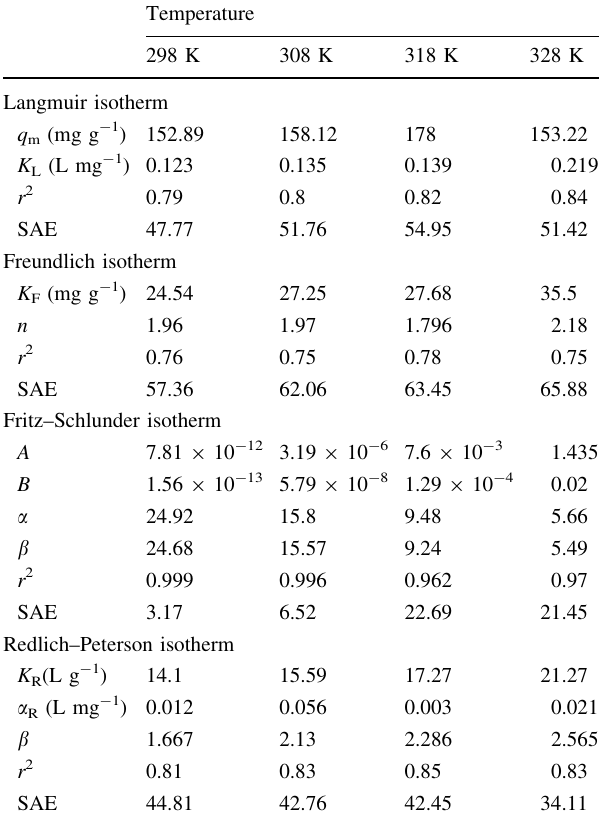
Table 2 Adsorption isotherm constants for MB removal